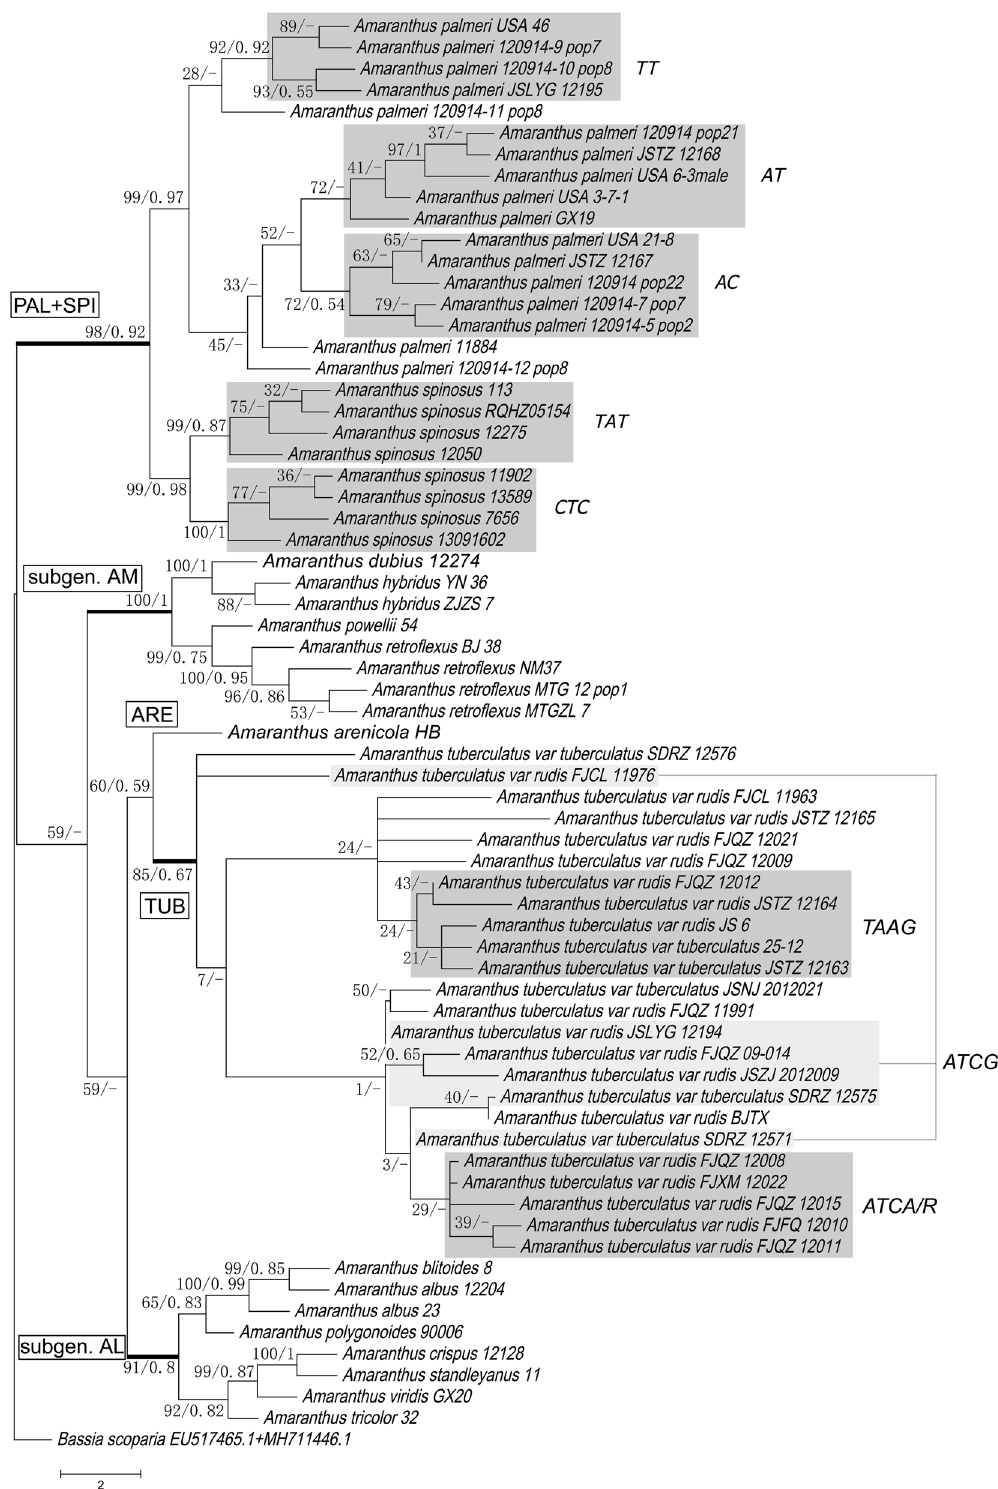
Figure 1. A maximum likelihood combined gene tree based on ITS and two regions within ALS of Amaranthus and one outgroup. Values at each node indicate maximum likelihood bootstrap support (BS)/Bayesian inference posterior probability (PP) value. Individuals marked with grey backgrounds represent genetically distinct